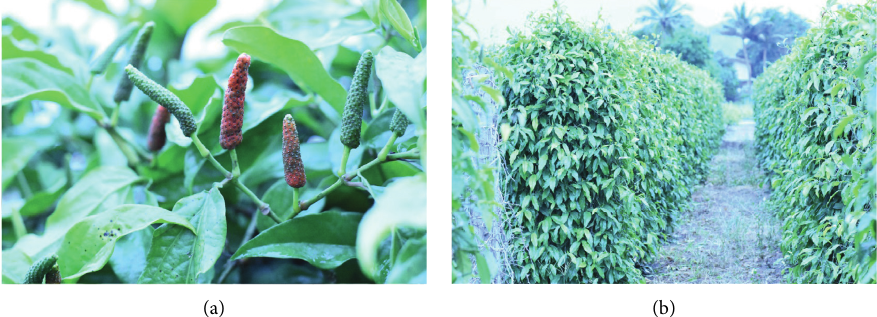
Figure 1: (a) Fruit of P. retrofractum Vahl consisting of many minuscule fruits each about the size of 5cm with poppy seeds embedded in the surface of a flower spike; the ripe fruit turns to a red-orange color. (b) A garden of long pepper as a climbing plant and it is held together with a